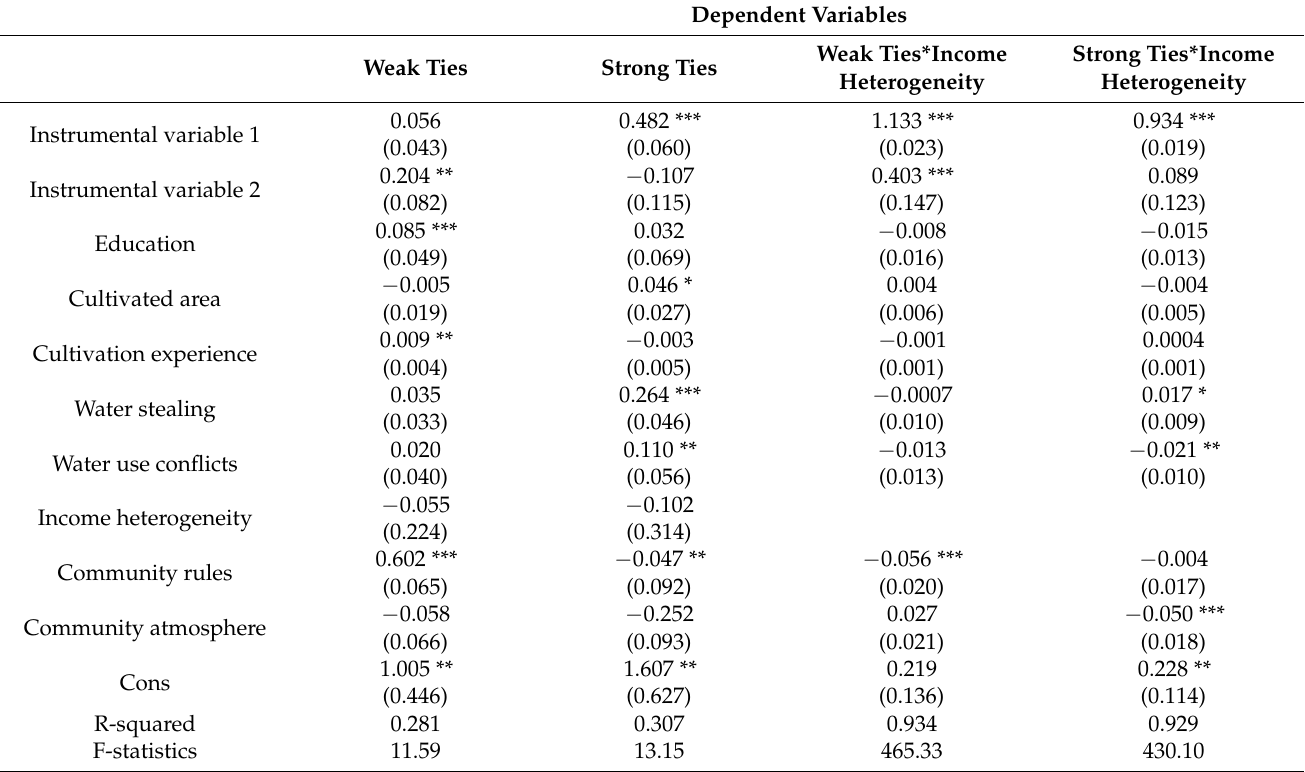
Table A1. The first stage result of the IV Probit